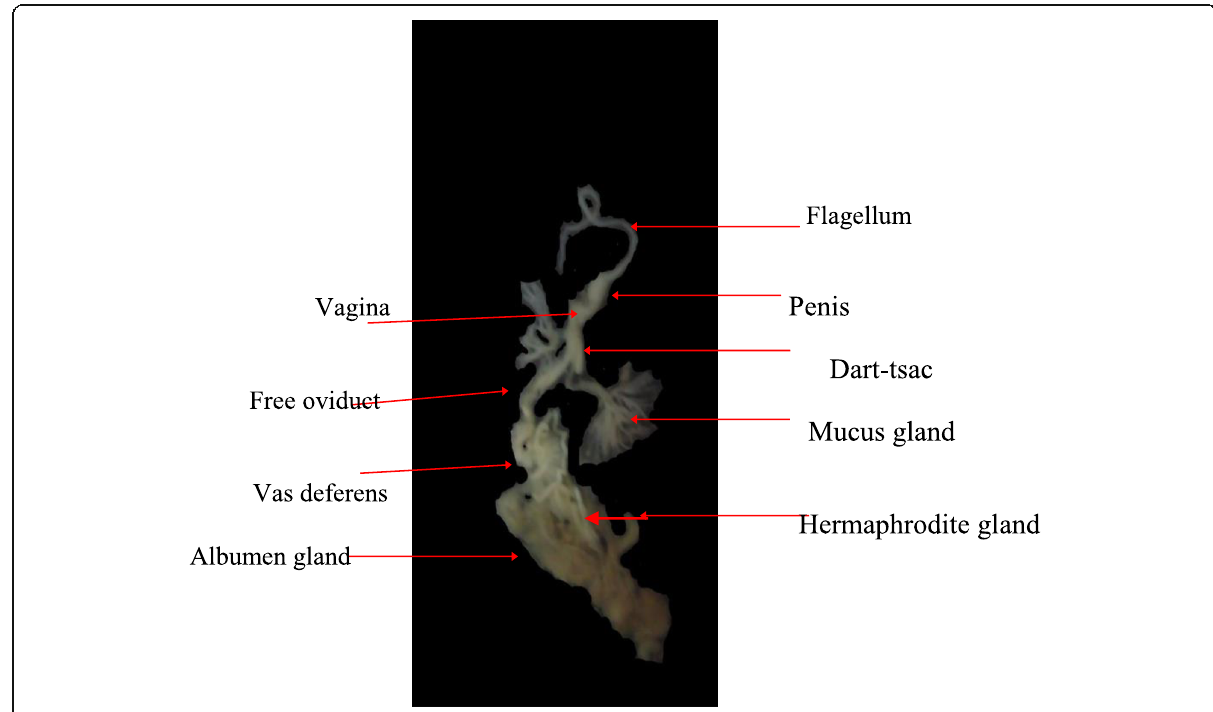
Fig. 2 Reproductive system of land snail, Eobania vermiculata treated with Emamectin benzoate